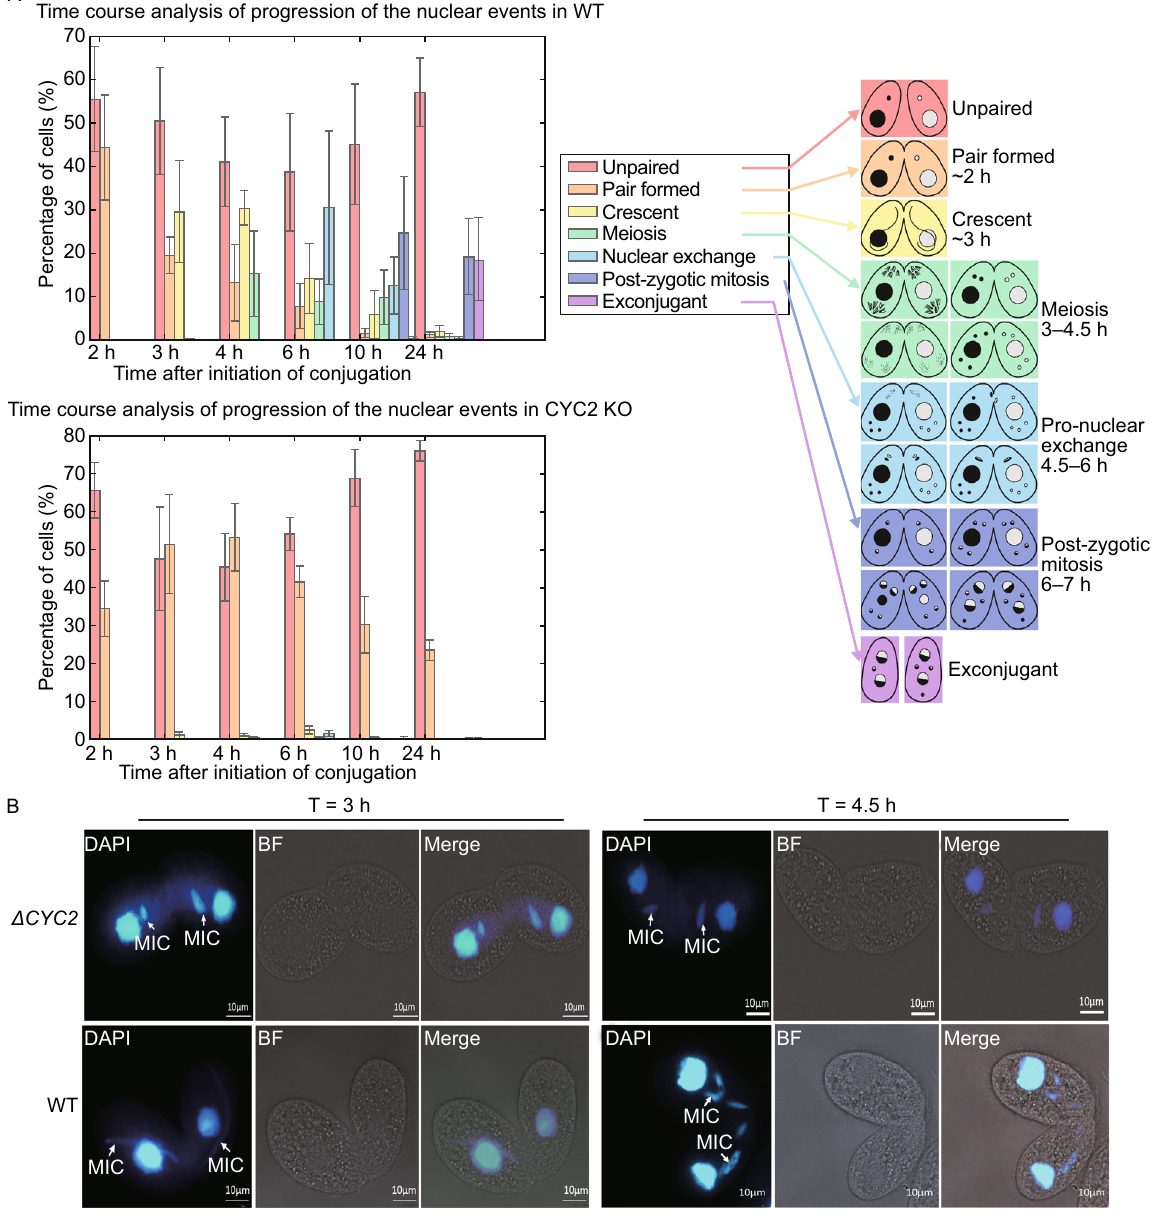
Figure 2. Phenotypic analysis of Δ CYC2 . (A) The time course analysis of the progression of the nuclear events showed that the loss of CYC2 resulted in an early conjugation arrest where the conjugants were not able to pass through the crescent stage successfully and lack of meiosis division. The conjugating process was arti fi cially separated into seven parts according to the morphology characteristics (unpaired, pair formed, crescent, meiosis divisions, pro-nuclear exchange, post-zygotic mitosis, and exconjugant) and the related graphical representation were highlighted in different color at the right side. The 4 independent biological repeats of cell samples were collected respectively at 2, 3, 4, 6, 10, and 24 h after conjugation initiation. At least 100 pairs of cells were counted in each repeat. The percentage of each morphologic status was calculated and displayed in the histographs above. (B) The status of cell cycle arrest of Δ CYC2 before crescent stage was captured during microscopic observation of cells stained with DAPI at 3 h when crescent shape formed in wild type conjugants and at 4.5 h when meiosis II was fi